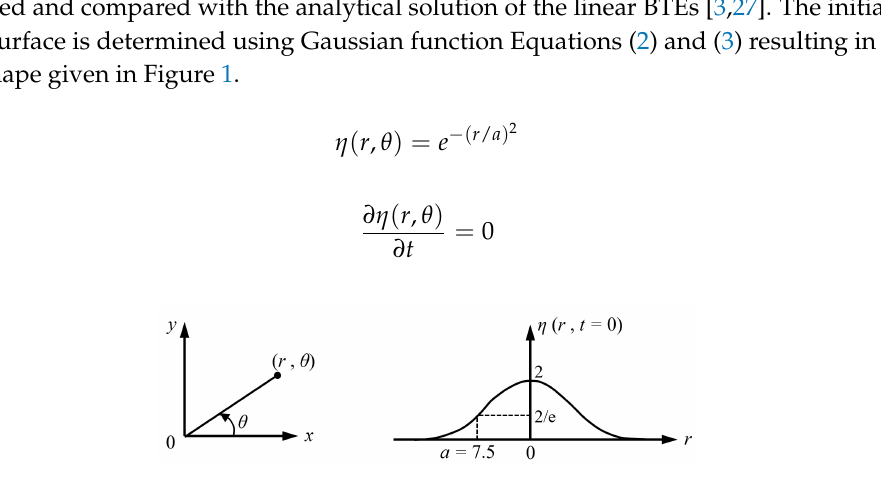
Figure 1. Profile of initial free surface and the coordinate system (adopted from